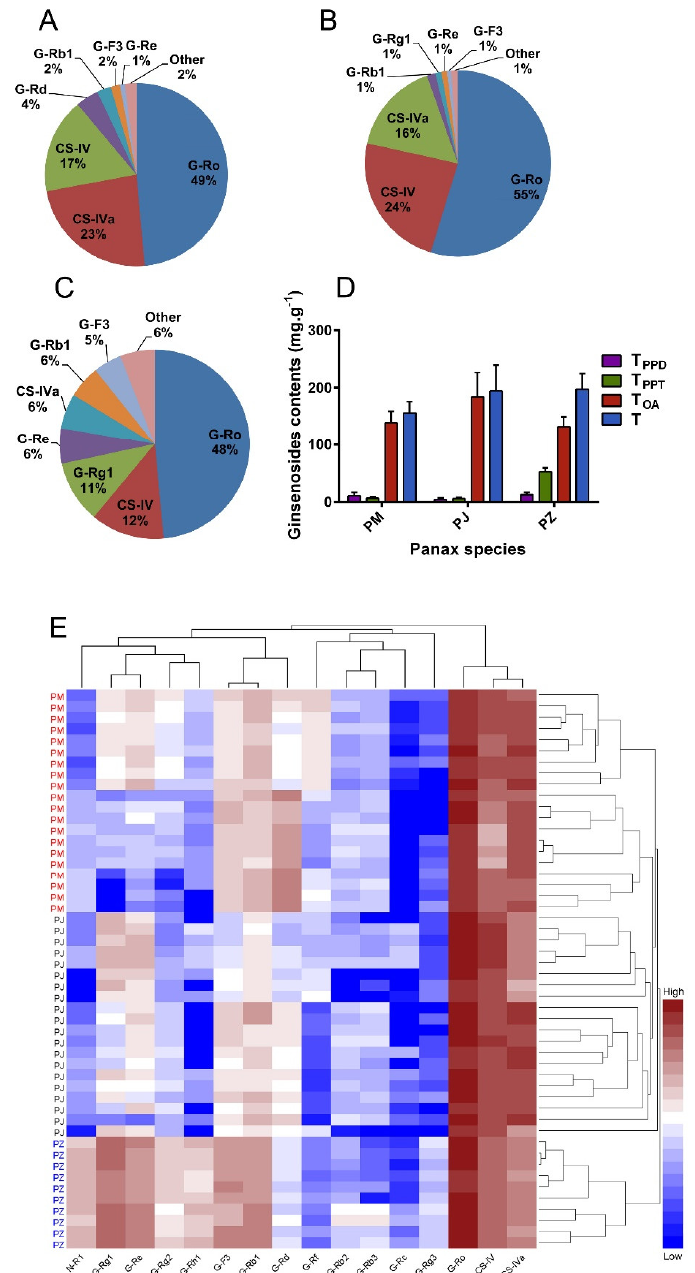
Figure 5. The percentage contents of the 16 ginsenosides ( A , PJ; B , PM; C , PZ) and total ginsenosides ( D ) in the three ginseng herbs; The content difference of 16 saponins by a two-way hierarchical clustering analysis heat map ( E ). Ginsenoside (G)-Rg1, G-Re, G-Rb1, G-Rc, G-Rb2, G-Rb3, G-Rf, G-Rd, G-Rg2, G-Rg3, G-F3, G-Rh1, G-Ro. Notoginsenoside (N)-R1 and chikusetsu saponin (CS) -IV and CS-Iva.